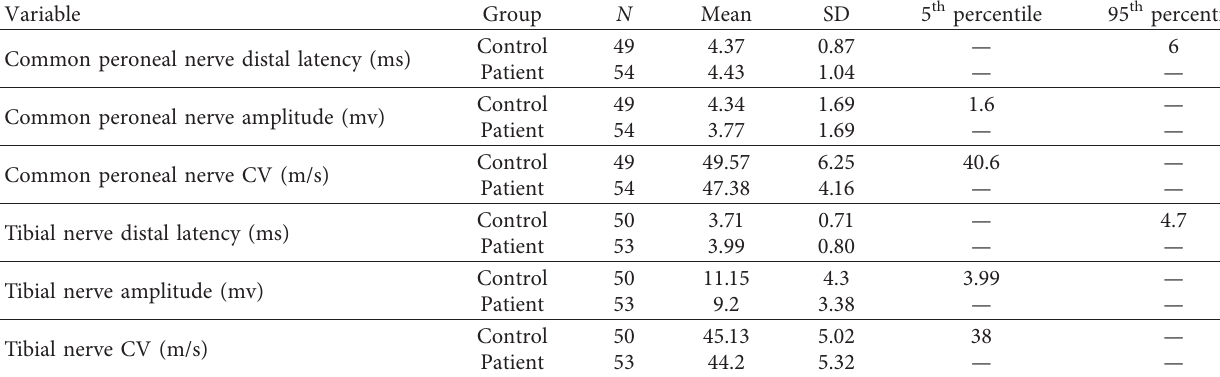
Table 2: CMAP parameters (patients group and control group).